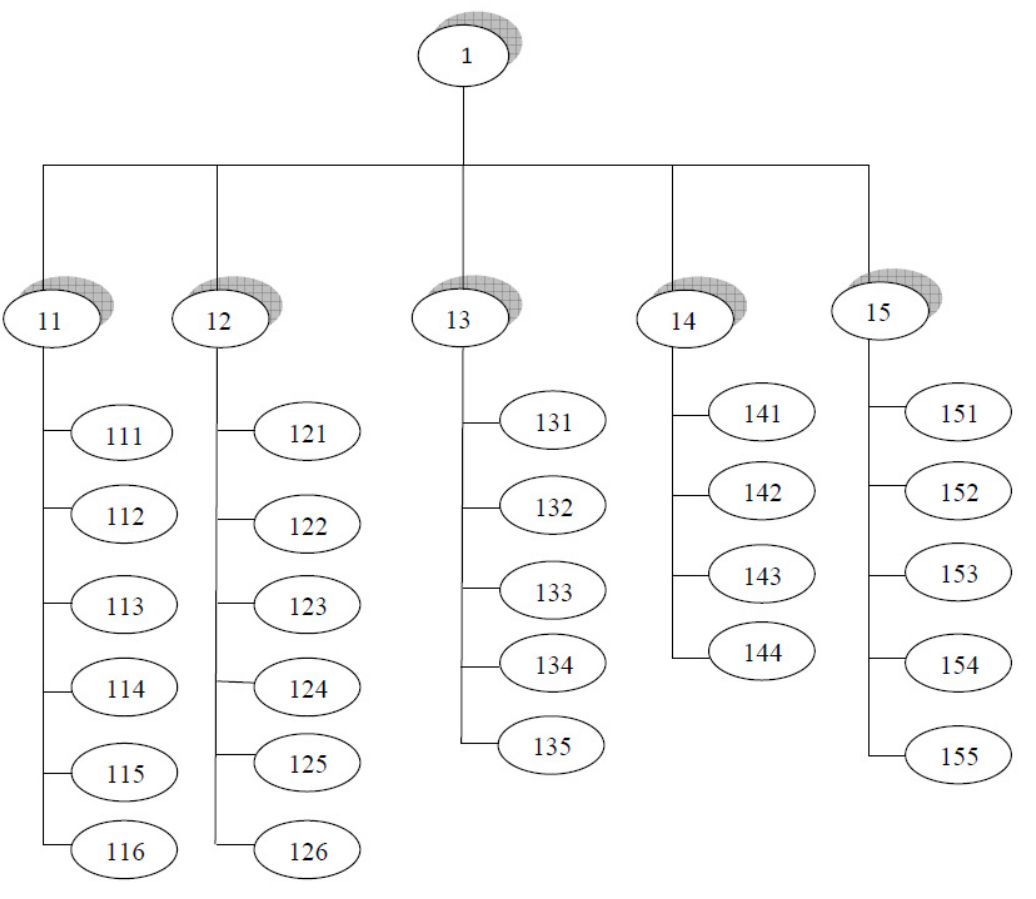
Figure 4. Structure of the BN for STPP.